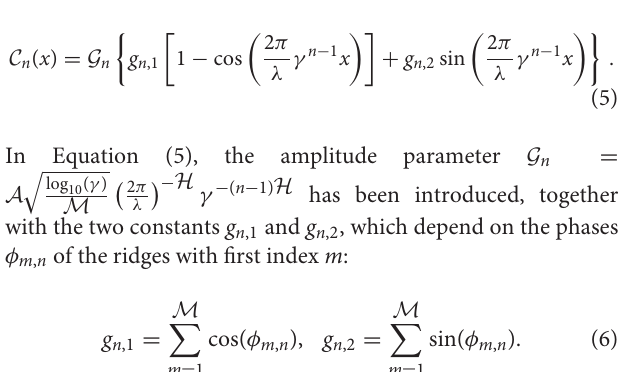
vector with components (